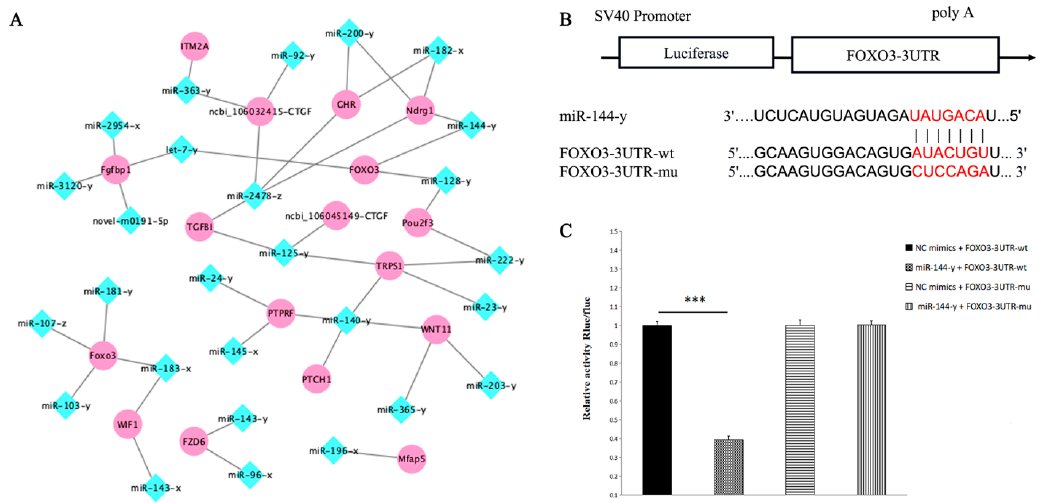
Figure 8. miRNA-mRNA interaction network and targeting validation. ( A ) Part of the interaction diagram between miRNA and target mRNA; the diamonds in blue correspond to the miRNAs and the circles in pink indicate the gene abbreviations. ( B ) Schematic representation of miR-144-y binding to the FOXO3-3 ′ UTR target site. ( C ) Dual-luciferase reporter gene assay of miR-144-y interacting with FOXO3-3 ′ UTR. *** p < 0.001.